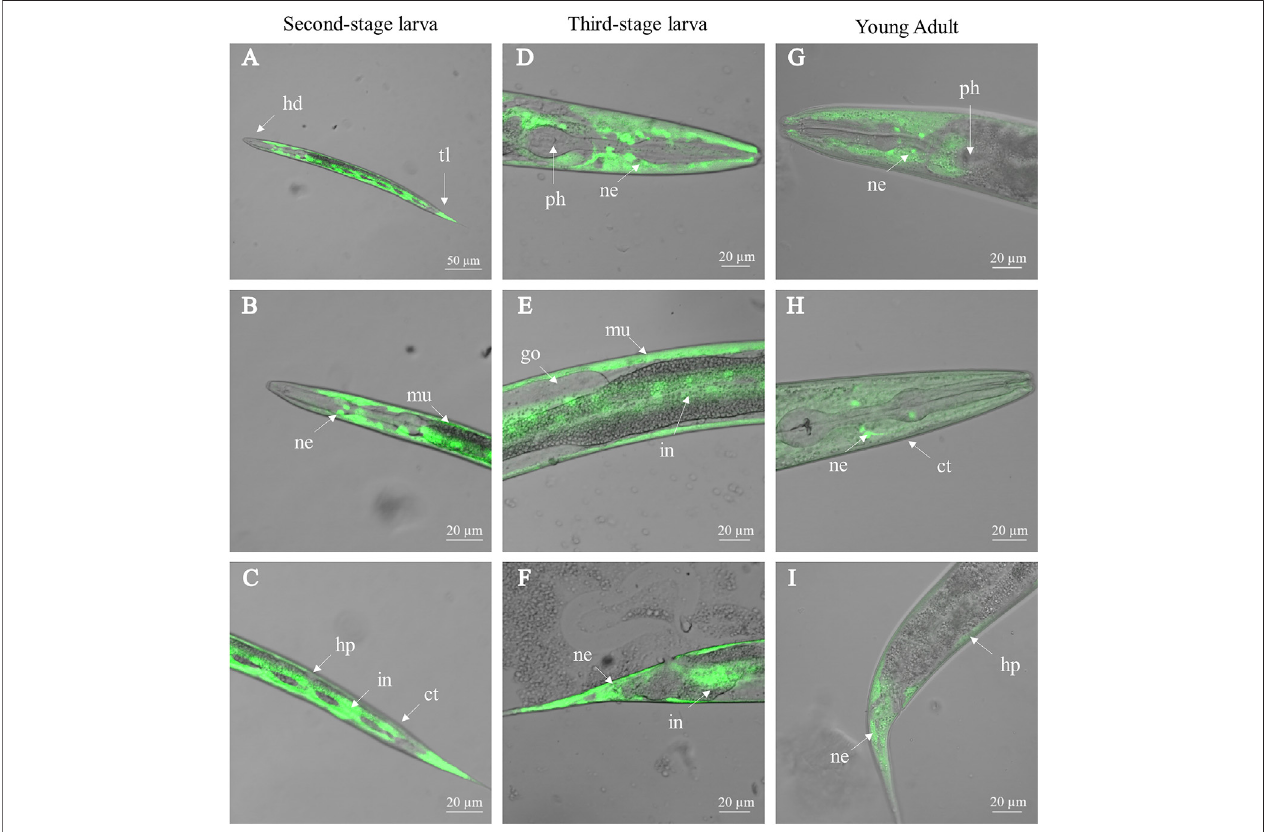
FIGURE 3 | Activity of Ce-ttr-31 promoter in Caenorhabditis elegans . Ce-ttr-31p : gfp is expressed in the second-stage larva (A – C) , third-stage larva (D – F) and adult (G – I) of C. elegans . Activities of Ce-ttr-31 promoter in neurons (ne), muscle layer (mu), intestine (in) and hypodermis (hp) are indicated. ct: cuticle, go: gonad, hd: head, ph: pharynx, tl: tail. Scale bar: 20 μ